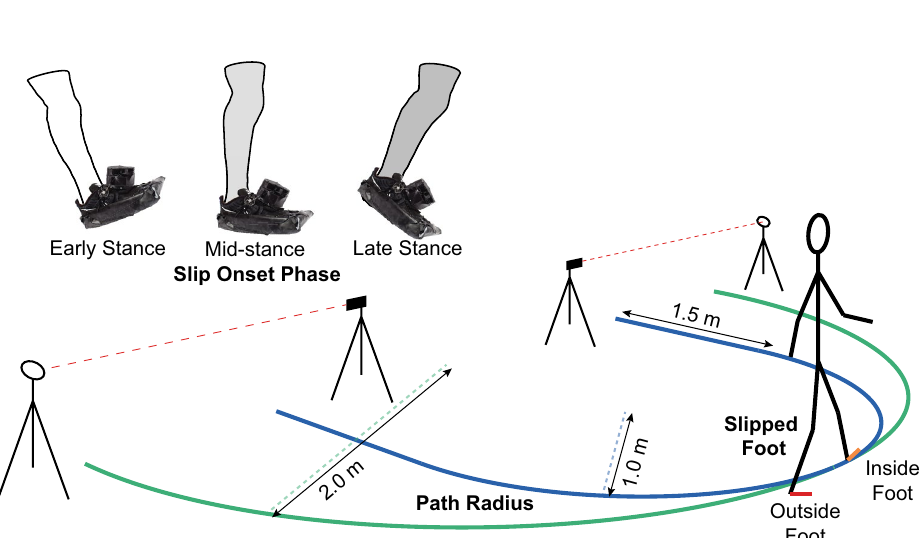
Figure 2. An illustration of the experimental set-up used in this study. 1.0 m and 2.0 m radius paths (blue and green paths, respectively) were marked on the floor with different colors of paper tape for easy identification, and the paths were tangent at their apexes. Straight sections of 1.5 m were added to both ends of the 1.0 m radius path to approximately equalize the lengths of the two paths and allow participants to accelerate to their self-selected walking speed before entering the curve. Participants walked back-and-forth along one path in each trial, following the curve with their inside foot relative to the path to ensure a natural step width and to place the CoM near the intended radius. A slip was delivered during each trial via WASP to either the inside or outside foot relative to the path (orange and red feet, respectively) at early, mid-, or late stance phases (white, light gray, and dark gray, respectively). Electronic timing gates spanned both ends of the paths as a method of measuring gait speed in real time for feedback purposes. Color coding of the three slip contexts in the results are consistent with this